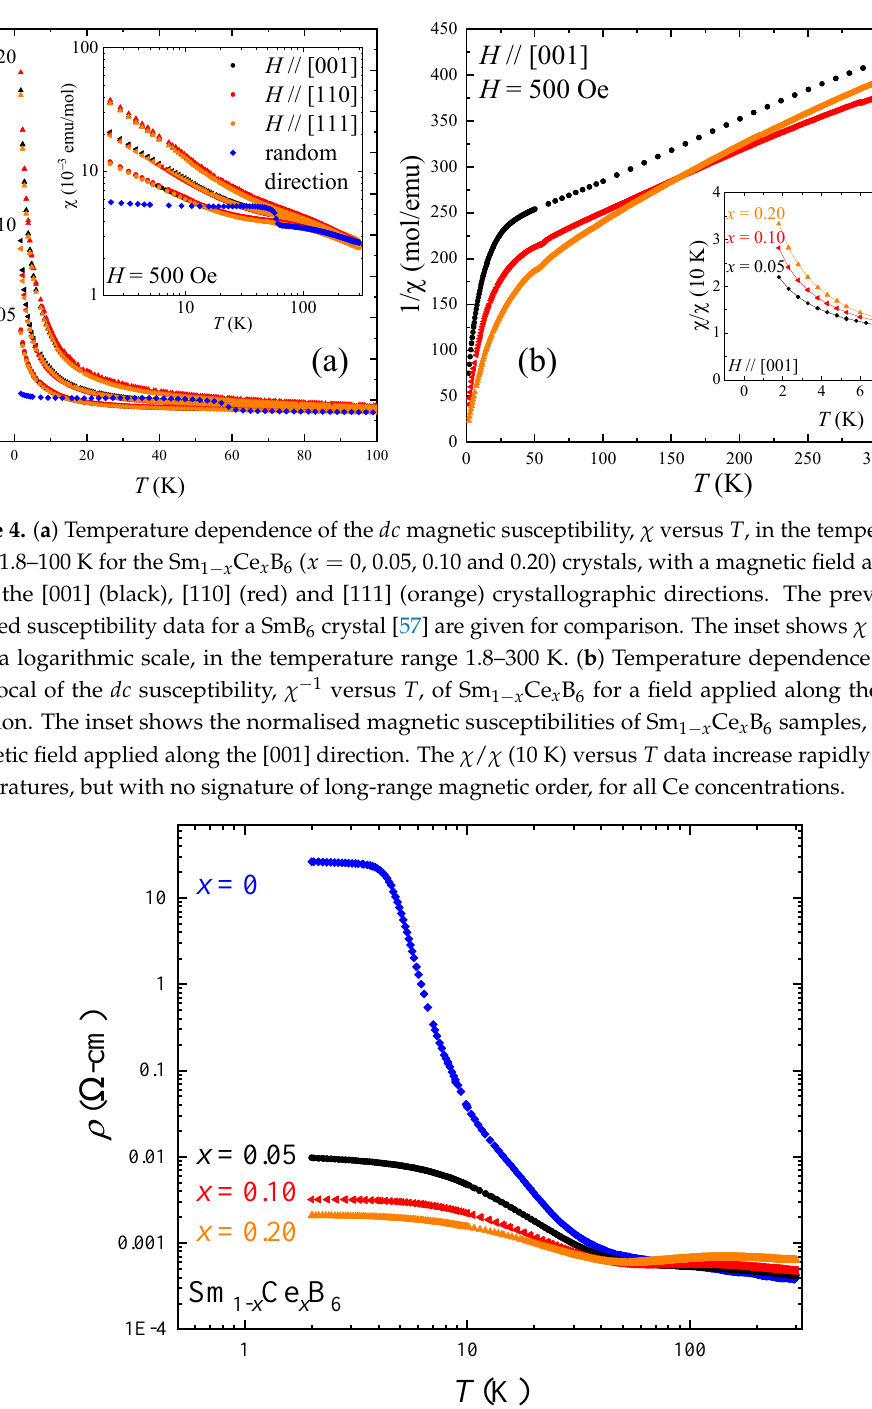
Figure 5. Temperature dependence of the bulk ac resistivity, ρ versus T , in the temperature range 1.8–300 K for the Sm 1 − x Ce x B 6 ( x = 0, 0.05, 0.10 and 0.20) crystals. The previously reported resistivity data for a SmB 6 crystal [57] are given for